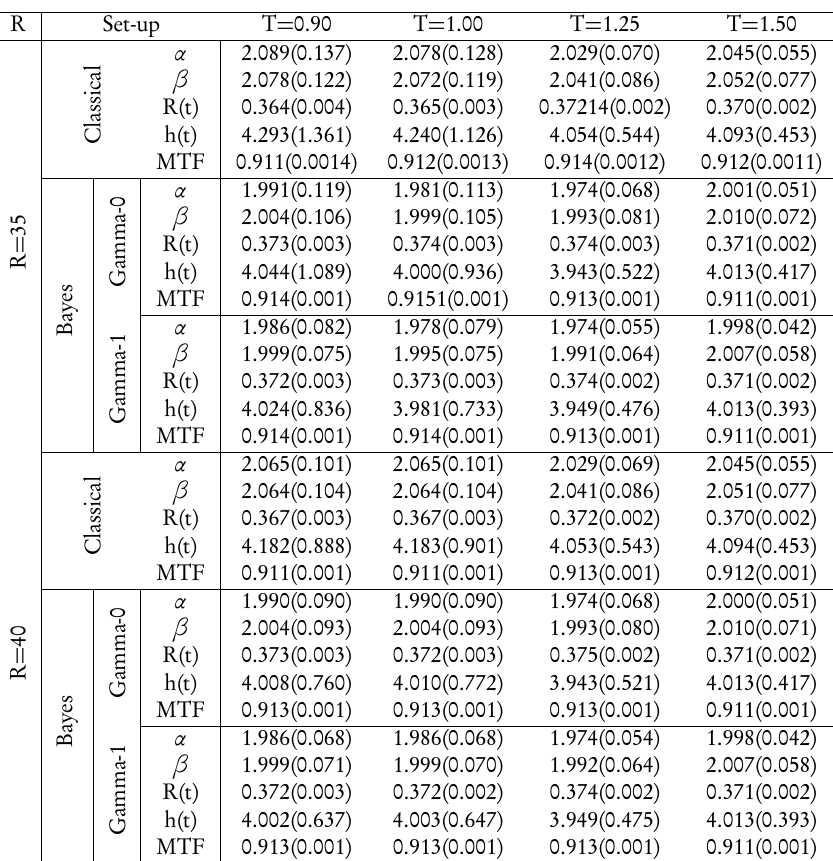
Average estimates of the parameters, reliability, hazard and MTF and corresponding MSEs (in brackets) with varying R and T for fixed n = 50 , α = 2 , β = 2 , R ( 1 ) = 0.3678 , h ( 1 ) = 4 and MTF = 0.9104